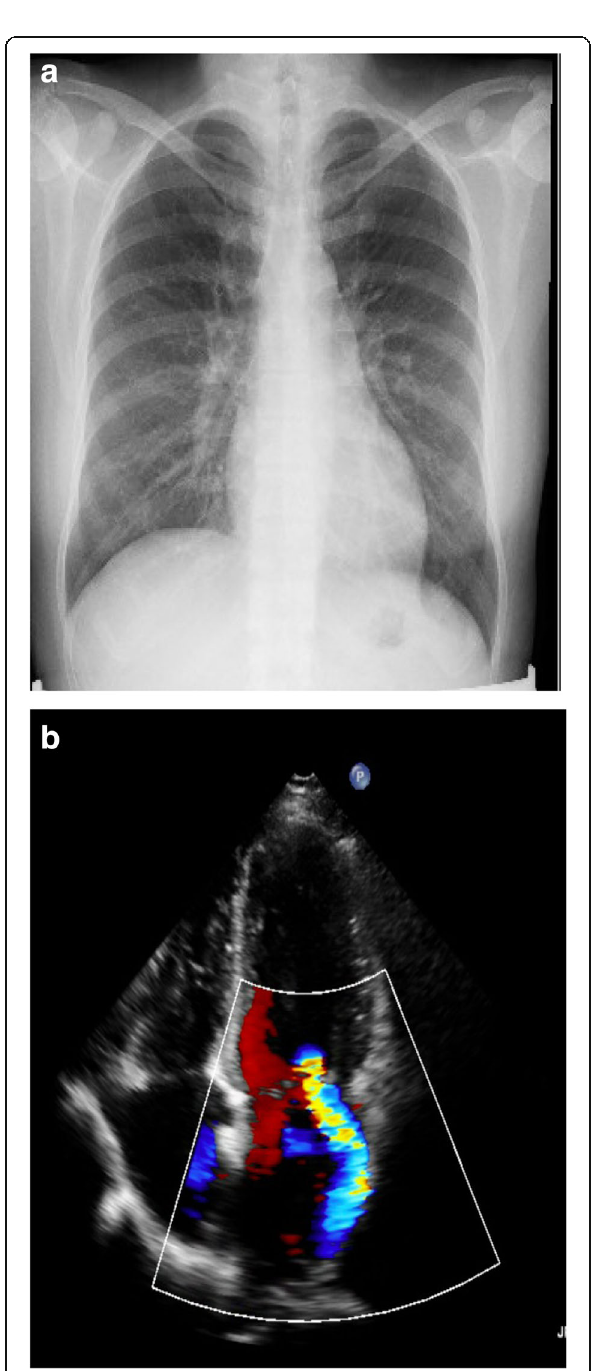
Fig. 1 Preoperative examinations. a Chest radiograph showing no abnormality. b Four-chamber view of a transthoracic